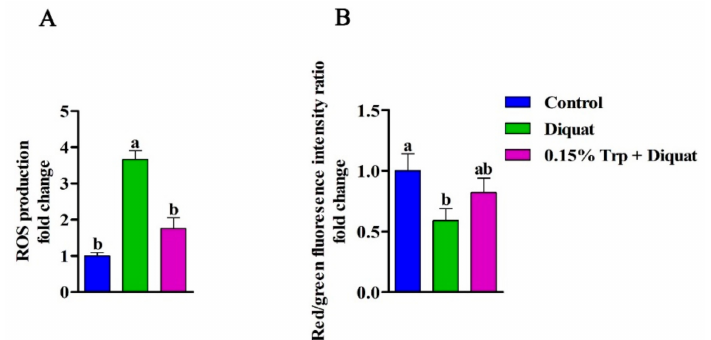
Figure 7. E ff ects of dietary tryptophan supplementation on intestinal mitochondrial reactive oxygen species (ROS) production ( A ) and intestinal mitochondrial membrane potential change ( B ) of piglets challenged with diquat. The ROS production and mitochondrial membrane potential were expressed as fold changes, calculated relative to the control group. Data are means ± standard error; n = 8 for each group. Mean values sharing di ff erent superscripts within the same row di ff er significantly ( p < 0.05). Control, piglets fed the basal diet without diquat injection; diquat, piglets fed the basal diet and challenged with diquat; 0.15% Trp + diquat, piglets fed the 0.15% supplemented diet and treated with